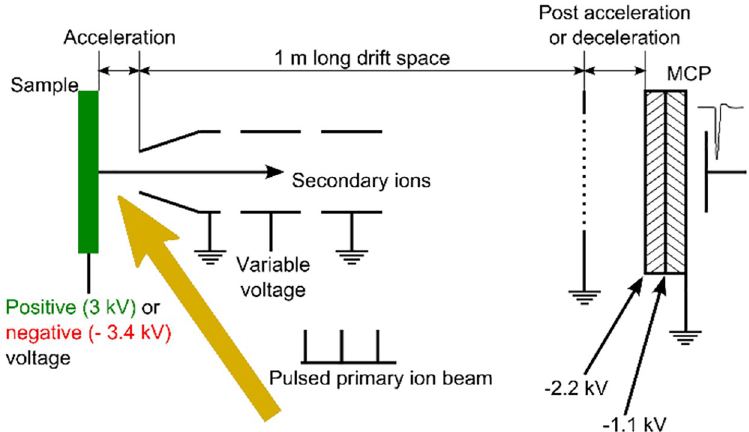
Fig 2. Operation of a linear TOF mass spectrometer mounted at 55˚ to the beam-line direction. The secondary ions are extracted by a voltage applied to the sample holder and directed by an Einzel lens toward the microchannel plate detector positioned at the end of a 1-m-long field-free drift